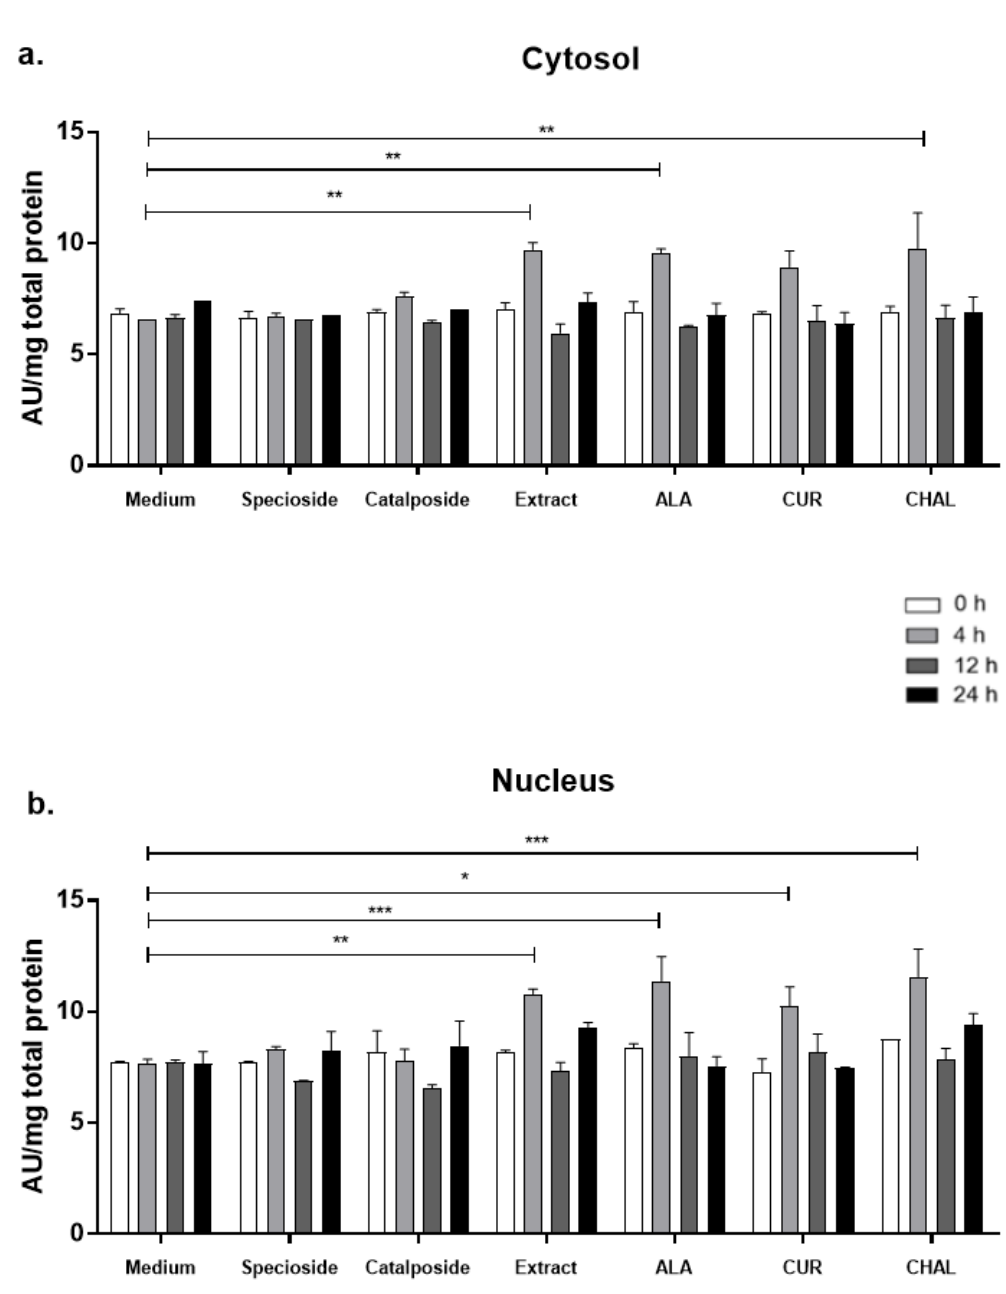
Figure 2. Nrf2 levels in cytosol ( a ) and nucleus ( b ) after 0, 4, 12 and 24 hours of exposure to 0.5 µM specioside, catalposide, controls and 0.25 µg/mL n -butanol extract. Kruskal-Wallis, Dunn’s post hoc. * p<0.05, ** p<0.01, *** p<0.001. ALA, α-lipoic acid; CUR, curcumin; CHAL, 2-trifluoromethyl-2ʹ-methoxychalcone.